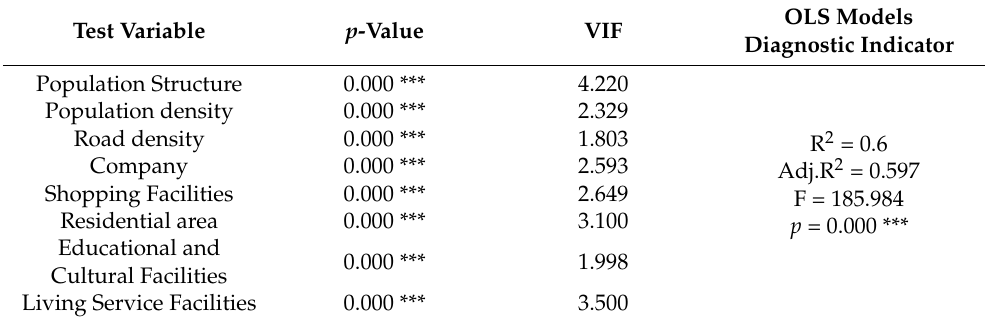
Table 2. Summary statistics of the OLS model on selected variables in modeling COVID-19 incidence risk.